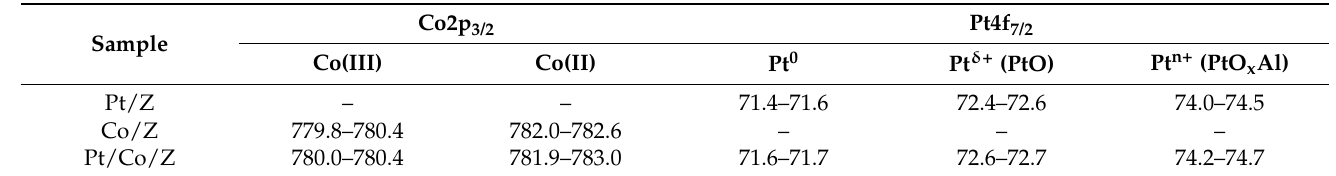
Figure 4. XP–spectra of ( a ) Pt4f and Al2p; ( b ) Co2p for 0.01Pt/4.5Co/Z-28; 0.01Pt/Z-28; and 4.5Co/Z-28. Table 3. Binding energies (eV) of the XPS components in the spectra of Pt- and Co-modified zeolites (BE Si2p =